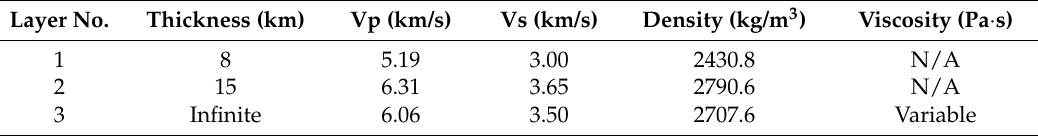
Table 2. Layered model used in this